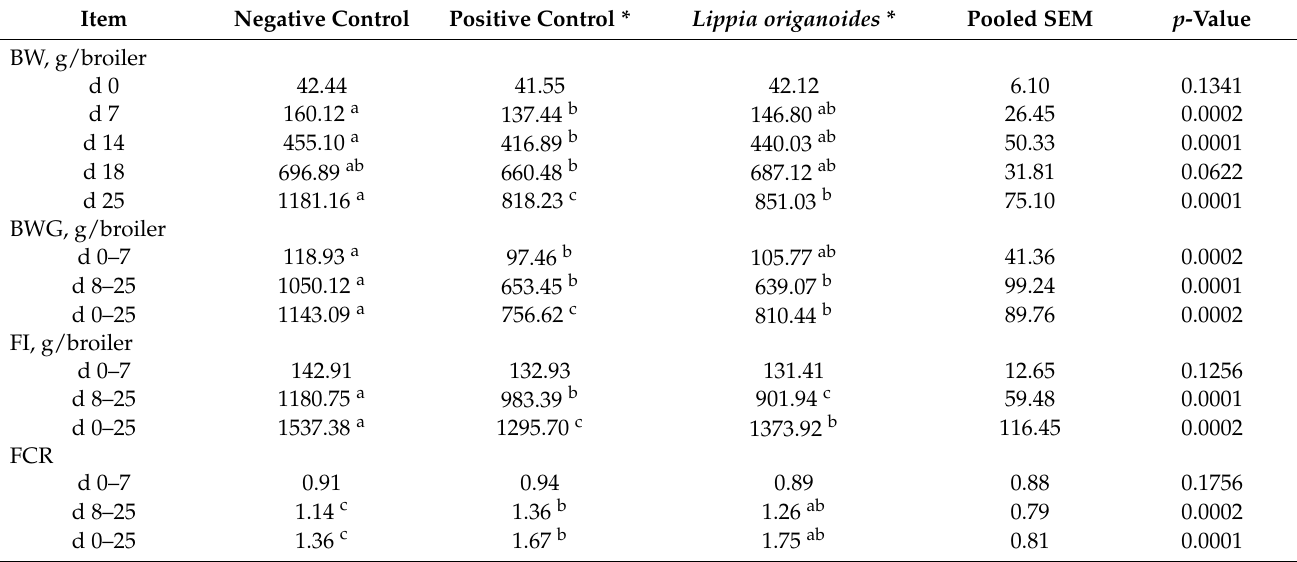
* Day-old broilers were challenged with Salmonella typhimurium (day 1), E. maxima (day 18), and Clostridium perfringens (days 22 and 23). a,b,c Non-matching superscripts within rows indicates significant difference at p <